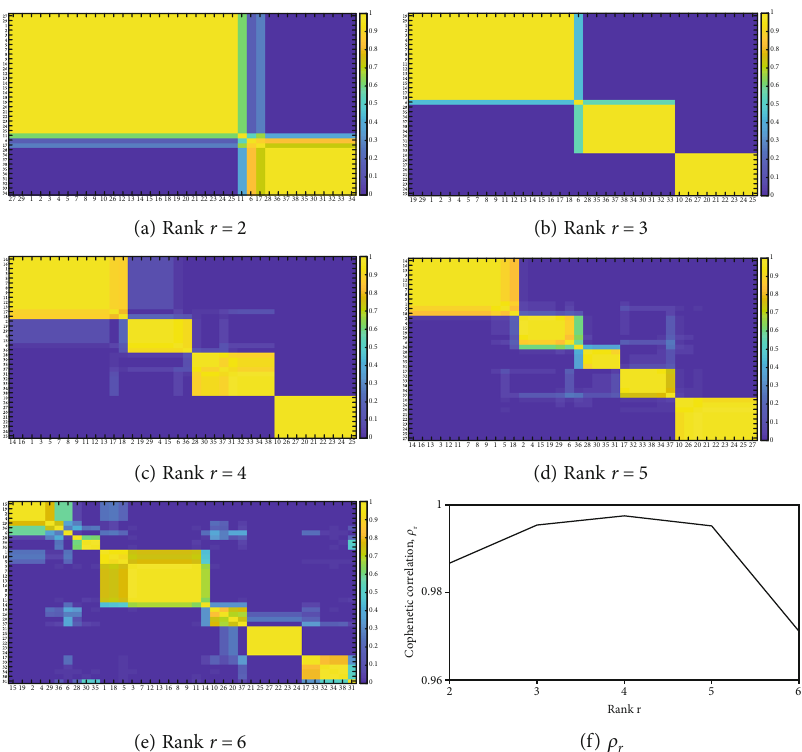
r = 2 ‐ 6 using ALL-AML. r for